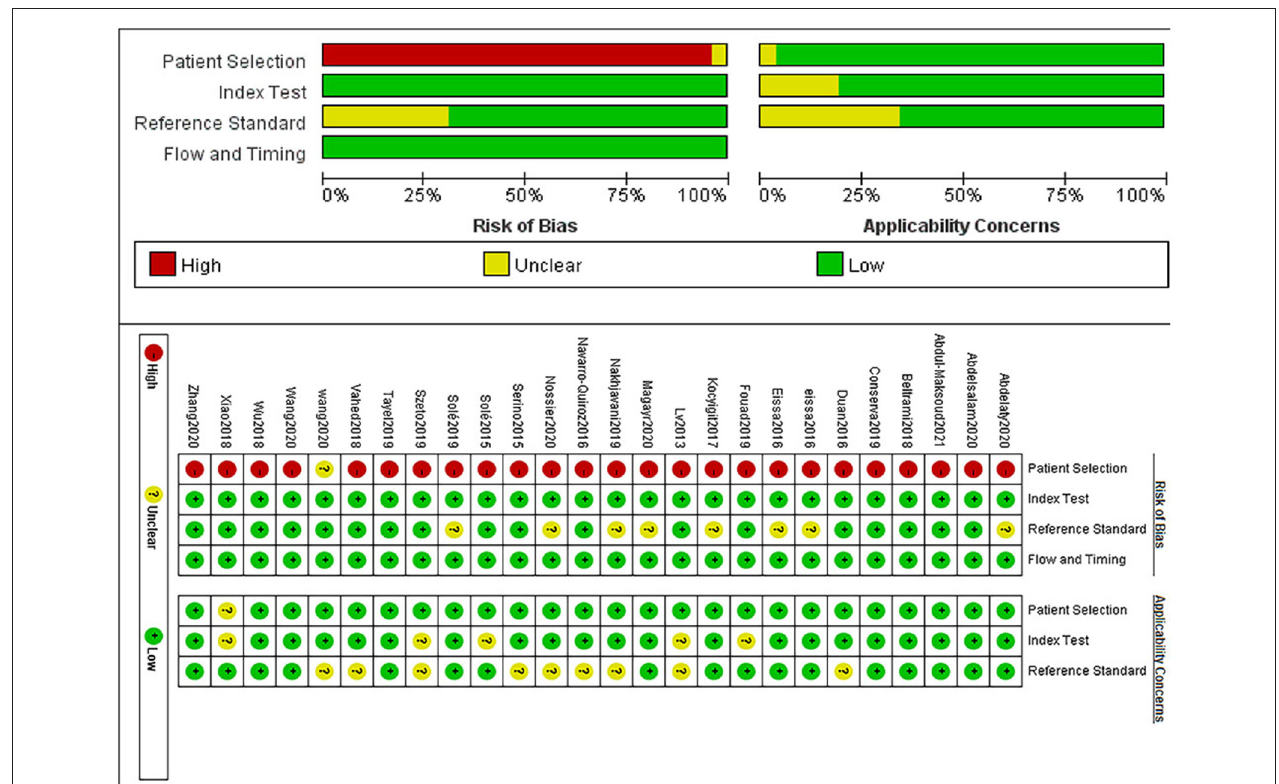
FIGURE 2 | QUADAS-2 assessment of risk of bias and applicability